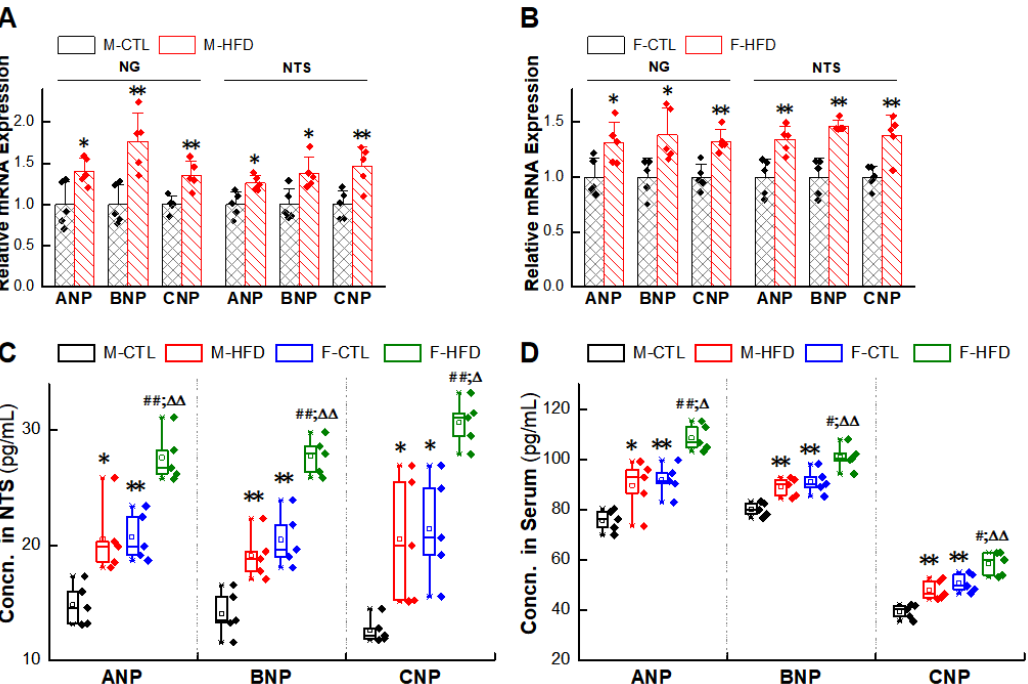
Figure 6. Upregulation of expressions of natriuretic peptides (NPs) in nodose ganglion (NG) and nucleus tractus solitarius (NTS) of high-fructose-drinking-induced hypertension (HFD) rat models. ( A , B ) mRNA expression of NPs. Averaged data was presented as mean ± SD. GAPDH means the internal control. * p < 0.05, ** p < 0.01 vs. male or female control rats, n = 5. ( C , D ) Concentrations of NPs measured with ELISA assay. Averaged data was presented as mean ± SD. * p < 0.05, ** p < 0.01 vs. M-CTL, ## p < 0.01 vs. F-CTL, ∆ p < 0.05, ∆∆ p < 0.01 vs. M-HFD, n = 5.